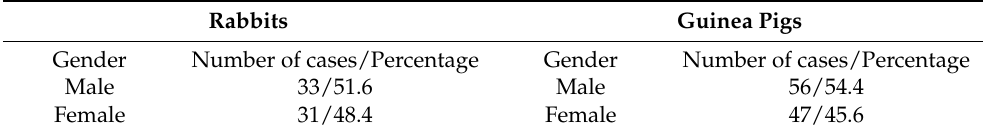
Table 1. Tested animals based on gender. Rabbits Guinea Pigs Gender Number of cases/Percentage Gender Number of